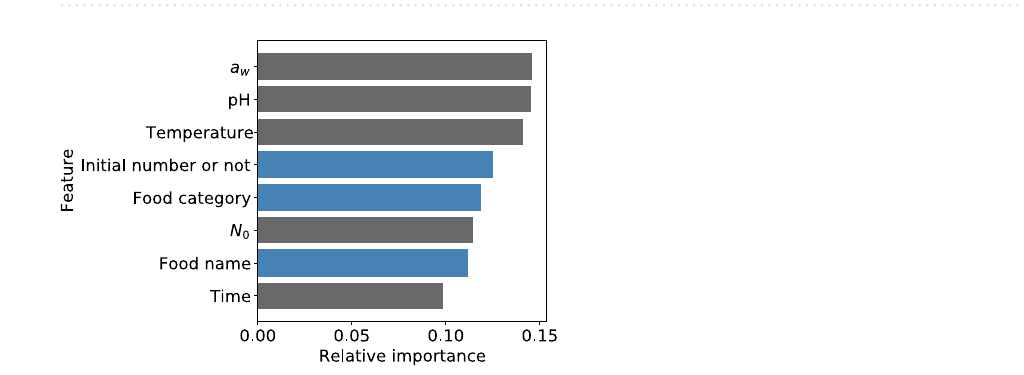
Figure 1. Histograms of the number of observed points for each variable (viable counts ( a ), initial cell numbers ( b ), temperature ( c ), pH ( d ), water activity ( e ), and food category ( f )). The black and gray bars show the number of training data and test data, respectively.